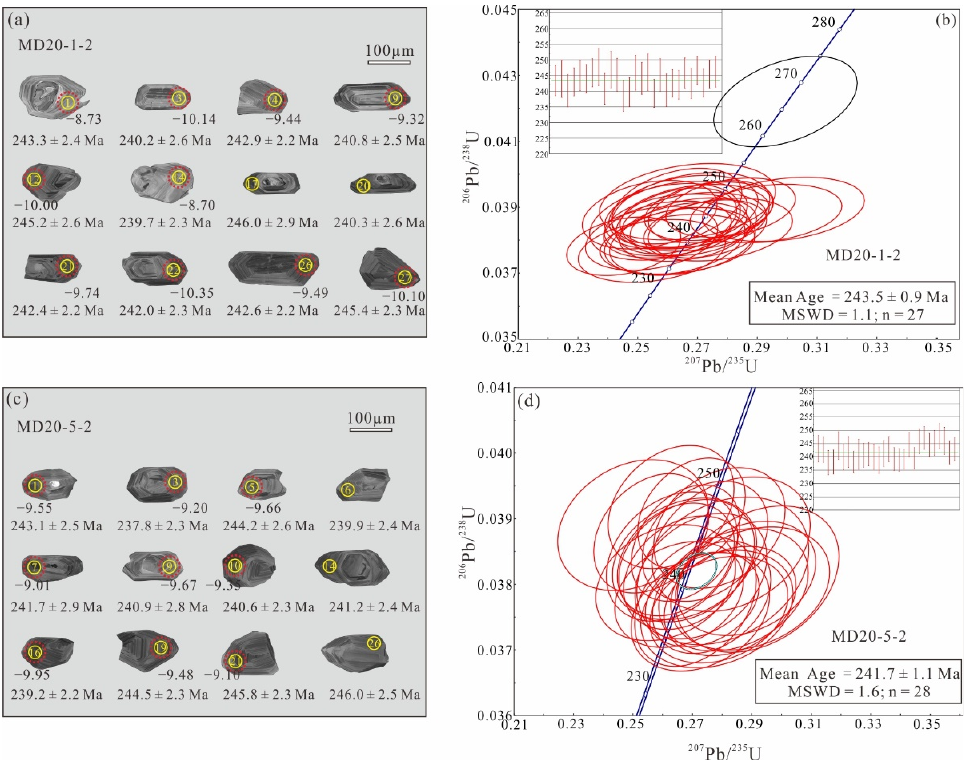
Figure 5. Cathodoluminescence images of representative zircon ( a,c ) and zircon U-Pb concordia plots ( b,d ) for the Madeng dacite.